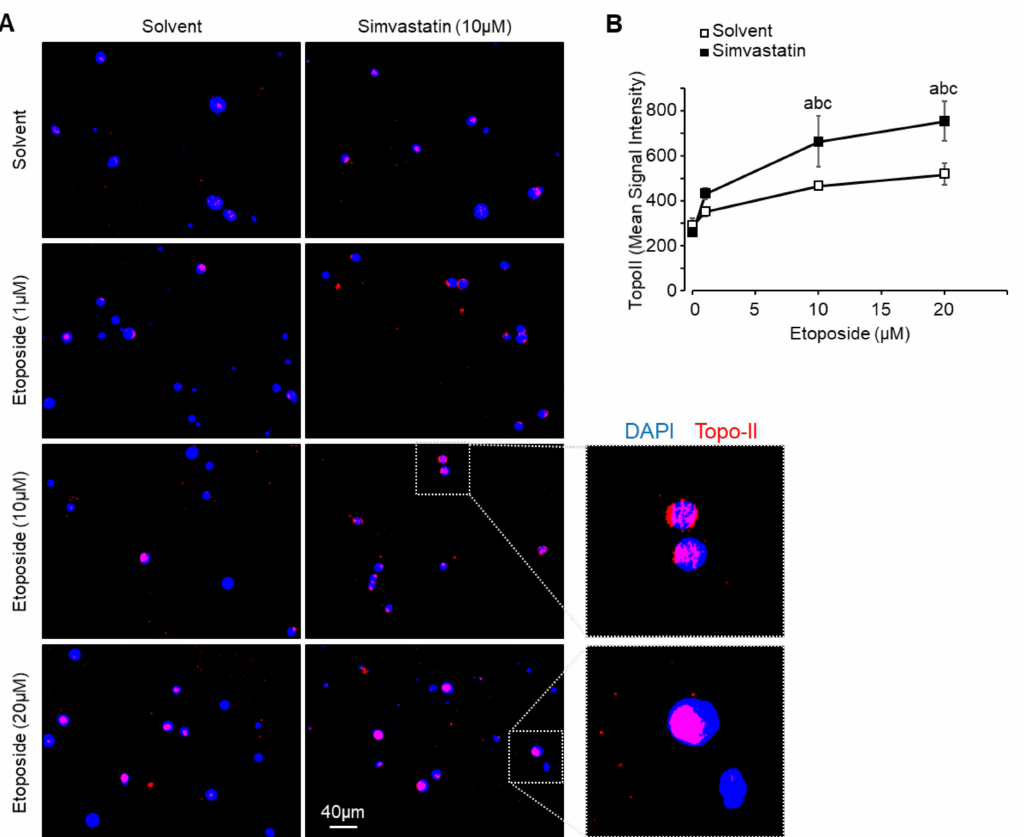
Figure 5. Simvastatin favors etoposide access to DNA. ( A ) Concentration-dependent topoisomerase II (Topo II)-DNA adducts formation. Cells were exposed to increasing concentrations of etoposide for 1 h in the presence or absence of simvastatin (10 µ M) and subjected to TARDIS analysis. Immunofluorescence staining for merged DAPI stained nuclei (blue) and Topo II signal detected using Alexa488-labeled secondary antibody (red). ( B ) Quantification of Topo II signal intensity. Results are expressed as mean ± SEM. a: p < 0.05 compared to solvent. b: p < 0.05 compared to simvastatin alone. c: p < 0.05 compared to etoposide